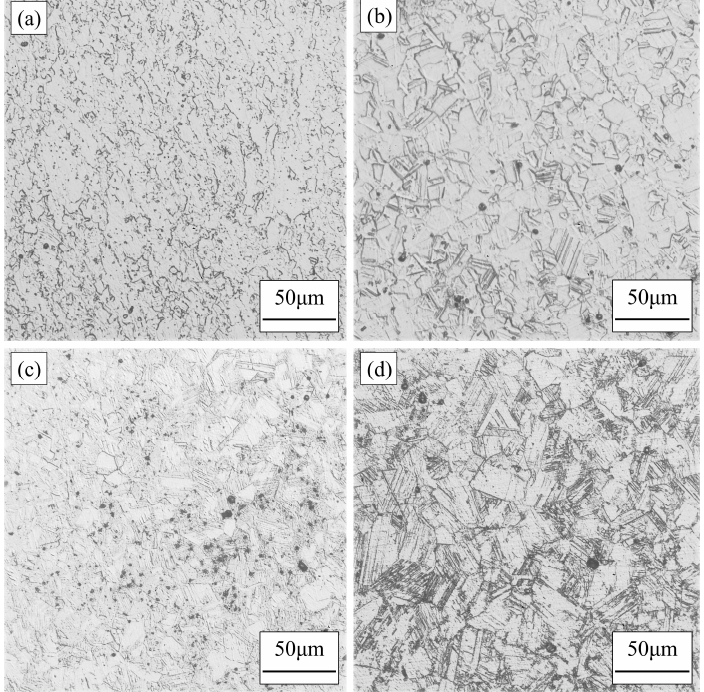
. ε = 0.5 s − 1 , ε = 0.9):